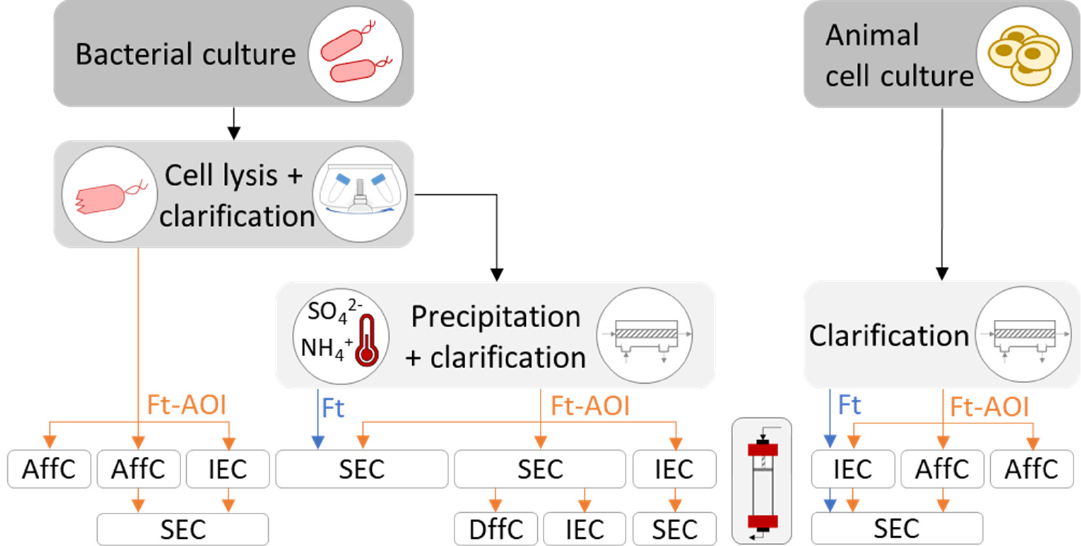
Figure 4. Strategies to produce and purify recombinant ferritin. AffC: affinity chromatography; DffC: differential centrifugation; Ft: ferritin; Ft-AOI: ferritin-antigen of interest; IEC: ion-exchange chromatography; SEC: size-exclusion chromatography.